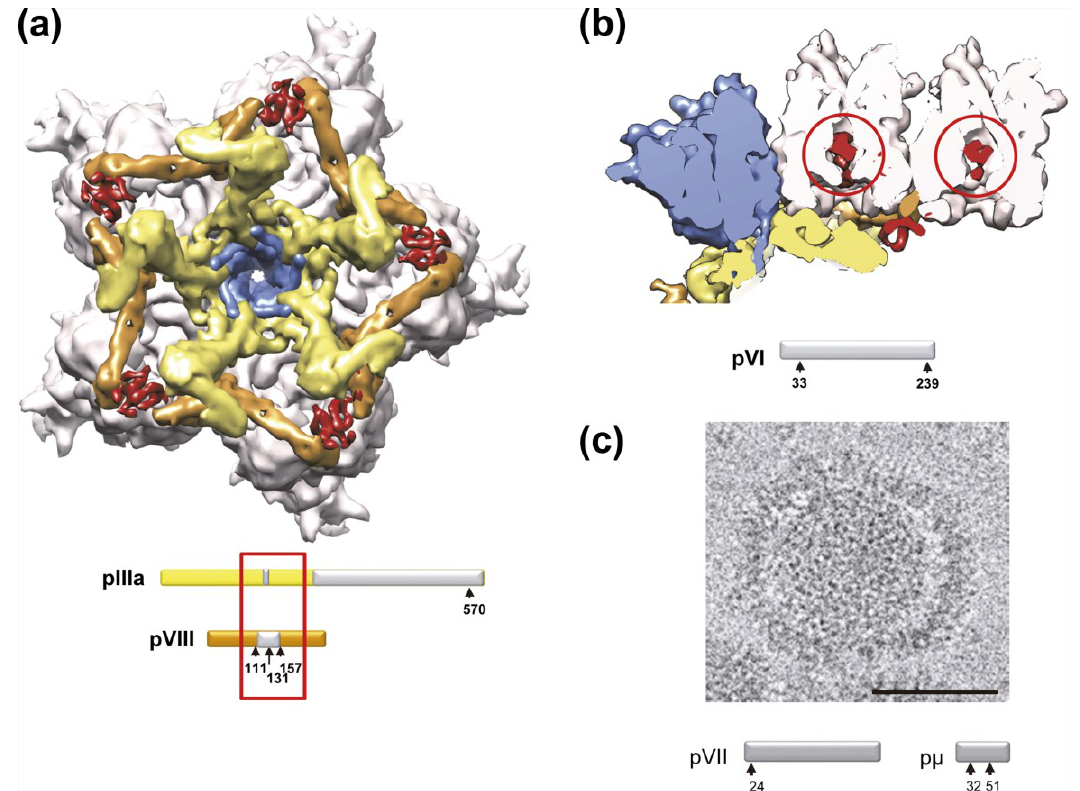
Figure 6. Structural differences between immature ( ts1 ) and mature (wt) AdV virions. ( a ) View from inside the capsid looking at the 5-fold icosahedral symmetry axis, with the density for the molecular stitch derived from the ts1 -wt difference map at 8.9 Å resolution in red [128]. The five peripentonal hexons are shown in pale pink; penton base in blue; polypeptide IIIa in yellow; and polypeptide VIII in tan. Surfaces in ( a ) and ( b ) were created from the HAdV-C5 high resolution cryo-EM structure (PDB ID 3IYN) [8] and represented with UCSF Chimera [90]. The bars represent the precursor polypeptides IIIa and VIII with the cleavage sites indicated (arrows). Polypeptide regions not traced in the cryo-EM HAdV-C5 high resolution structure are in gray. Untraced regions close to the molecular stitch are indicated with a red rectangle. Modified from [7]; ( b ) A section across the capsid showing the density attributed to the precursor of protein VI (red circles) inside the inner cavities of two hexon trimers [128]. Colors are as those shown in ( a ). Density for the molecular stitch is also seen in this view, wedged between polypeptide IIIa and VIII. The bar represents the precursor polypeptide VI with the cleavage sites indicated (arrows); ( c ) A disrupted particle found in a cryo-EM preparation of ts1 virus, showing the capsid separating from the core, while the latter remains as a compact sphere. The bar in the micrograph represents 50 nm. The bars below represent the precursor polypeptides pVII and pμ with the cleavage sites indicated (arrows). Reproduced with permission from Reference [128]. Copyright 2009,